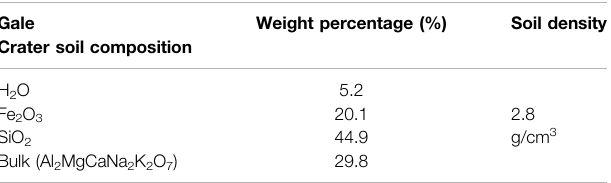
TABLE 1 | Basaltic soil composition from APXS analysis of Rocknest soil at Gale Crater (Blake et al., 2013; Hassler et al., 2014). Gale Crater soil